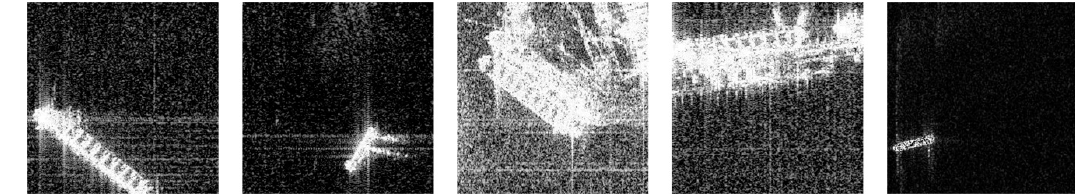
Figure 6. Samples of the ship chips in the constructed dataset.